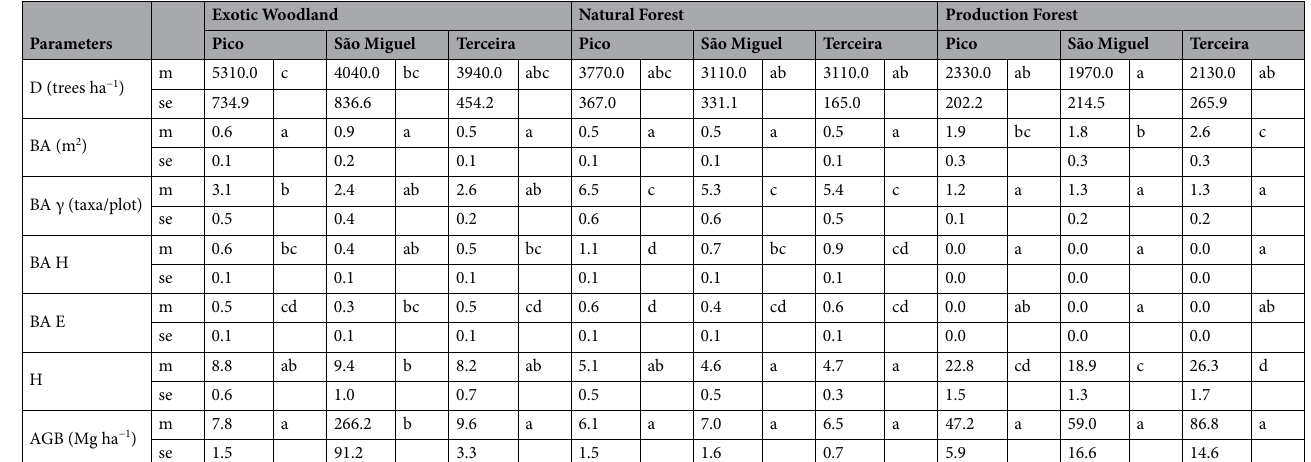
Table 6. Structural diversity found at 90 forests in the Azores, from three islands (Pico, São Miguel, and Terceira) and three forest types (Exotic Woodland, Natural Forest, and Production Forest). Mean and standard error for each structural parameter. Tree density (D, trees ha −1 ), Basal area (BA, m 2 ), BA γ (number of taxa contributing to the BA, i.e., those with a diameter at breast height above 2.5 cm), Shannon diversity based on BA (BA H), Evenness based on BA (BA E), aboveground biomass (AGB Mg ha −1 ). For each row, different letters indicate significant differences (p < 0.05) according to the results of a Tukey test applied after